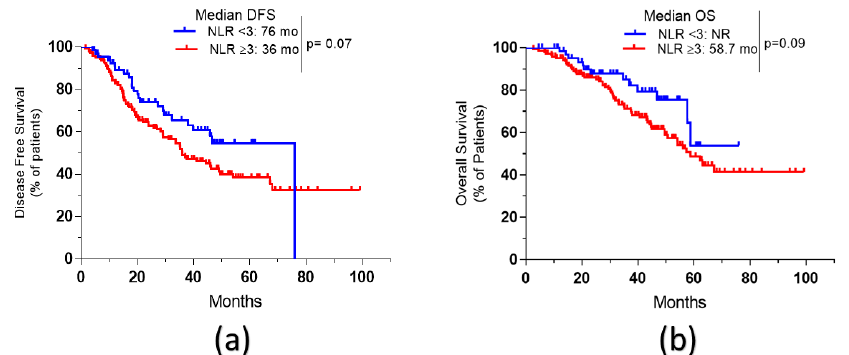
Figure 3. Survival curves of older patients with resectable CRLM according to NLR. ( a ): disease- free survival (DFS) of patients with NLR < 3 compared to patients with NLR ≥ 3. ( b ): overall sur- vival (OS) of patients with NLR < 3 compared to those with NLR ≥ 3. NLR: Neutrophil/Lympho- cyte Ratio.